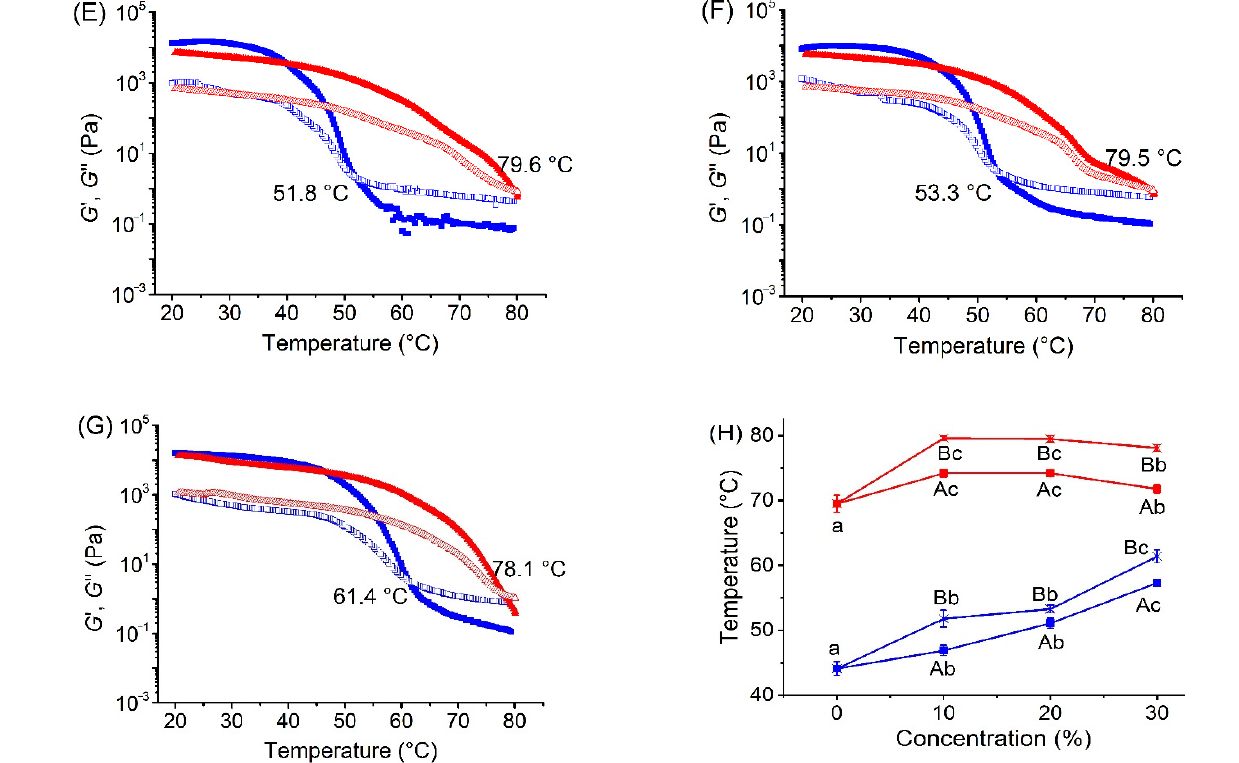
Figure 1. Storage modulus ( G ′ ) and loss modulus ( G ″ ) during temperature sweep for 2 wt% κ -carrageenan ( κ -C) with the addition of ( A ) 0 wt % xylitol and maltitol; ( B ) 10 wt % xylitol addition; ( C ) 20 wt % xylitol addition; ( D ) 30 wt % xylitol addition; ( E ) 10 wt % maltitol addition; ( F ) 20 wt % maltitol addition; ( G ) 30 wt % maltitol addition ( ■ : G ′ -cooling; □ : G ″ -cooling; ▲ : G ′ -melting; △ : G ″ -melting). ( H ) The transition temperature of different samples (red line: melting temperature ( T m ); blue line: gel temperature ( T g ); square means the addition of xylitol; cross symbol means the addition of maltitol; different lowercase letters mean significant difference among different concentration, and different uppercase letters mean significant difference between xylitol and maltitol addition).